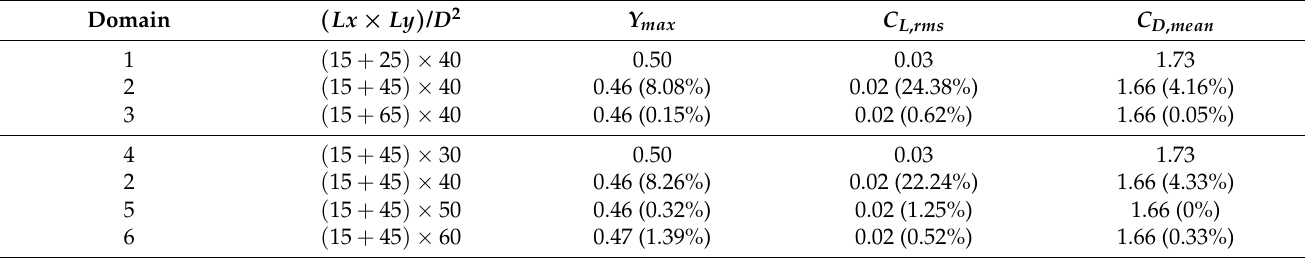
Table 2. Dependence of numerical results on the size of the computational domain. All the numerical simulations were conducted at fixed values of L u / D = 15, Re = 150, m ∗ = 2.5465, ζ = 0, and U r =